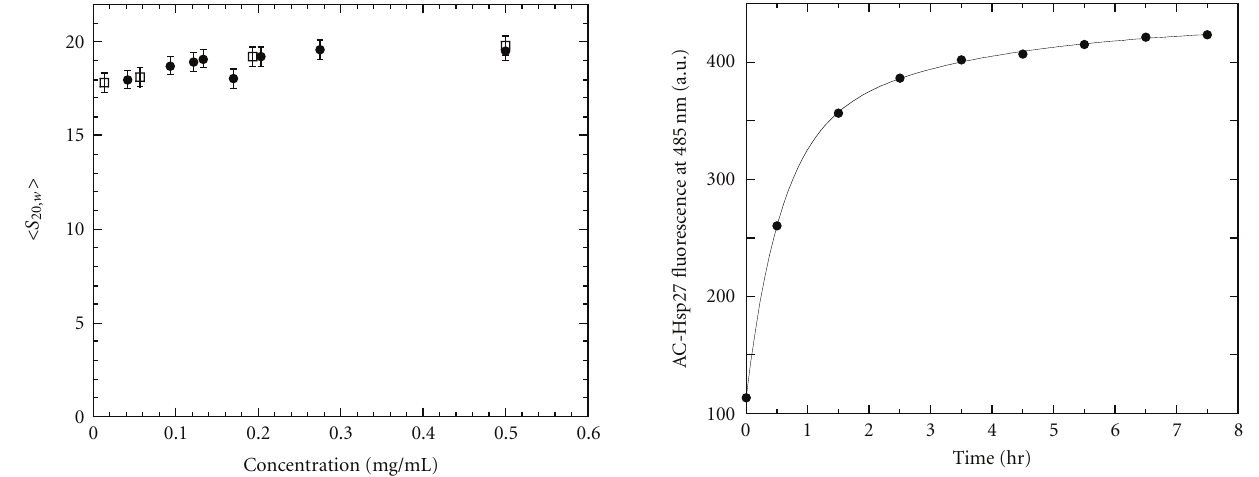
Figure 1: Weight average sedimentation coe ffi cient, corrected to 20 ◦ C in water, versus concentration of Hsp27 (closed circles) or AC- Hsp27 (open squares). Bu ff er = 120 mM NaCl, 25mM Tris, 2mM MgCl 2 , 0.2 mM EGTA, 0.01% NaN 3 , 50 μ M PMSF, 5mM DTT, and pH 7.5. The standard deviation of the data points is propagated from the noise in the original data set as described [37].